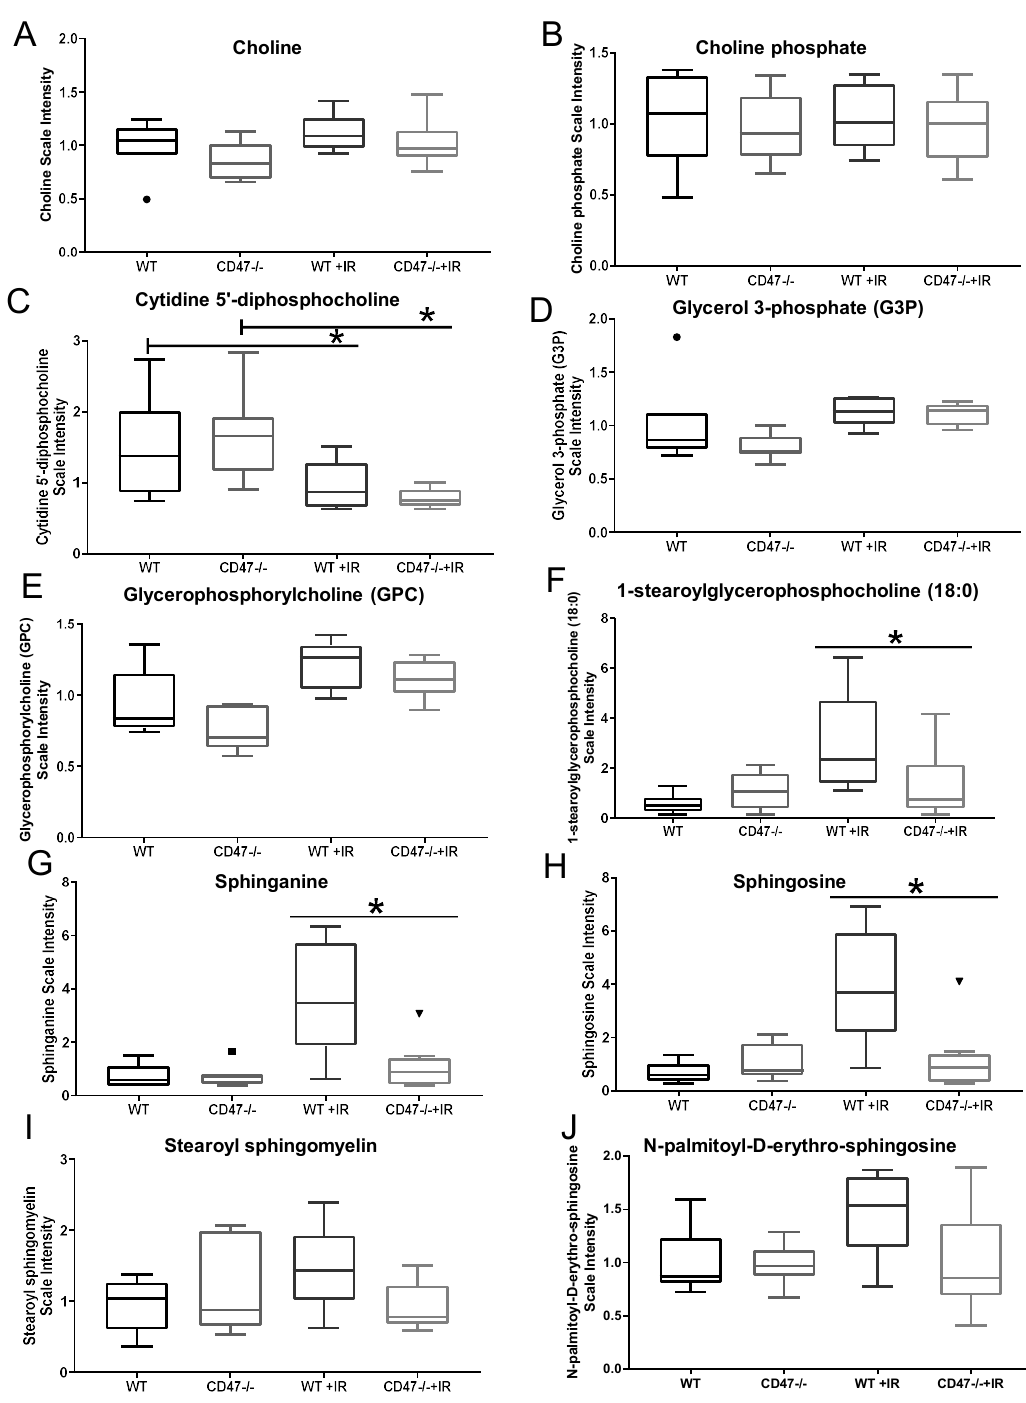
Figure 4. Regulation of cell membrane lipid metabolites after exposure to ionizing radiation. ( A ) Choline, ( B ) Choline phosphate, ( C ) Cytidine 5’-disphosphocholine, ( D ) Glycerol 3-phosphate, ( E ) Glycerophosphorycholine, ( F ) 1-stearolglycerophosphocoline, ( G ) Sphingannine, ( H ) Sphingosine, ( I ) Stearoyl sphiongomyelin and ( J ) N-palmitoyl-D-erythro-sphingosines were measured in lungs of mice exposed to ionizing radiation. Symbols denote outliers. (* p < 0.05, n = 7–8). 2.5. Absence of CD47 Preserves Nucleotide Metabolism after Ionizing Radiation Nucleotide biosynthesis is essential for mechanisms of DNA repair triggered by strand breakage caused by ionizing radiation. As expected, key intermediaries of purine metabolism were depleted